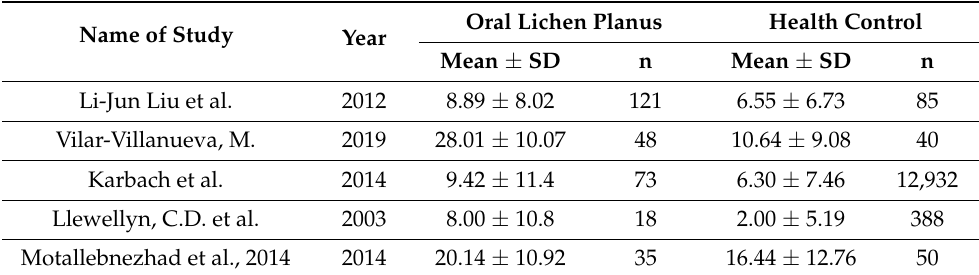
Table 2. Studies that compared Oral Health-Quality of Life (baseline) between patients with oral lichen planus and healthy controls using the Short-Form Oral Health Impact Profile (OHIP)-14.